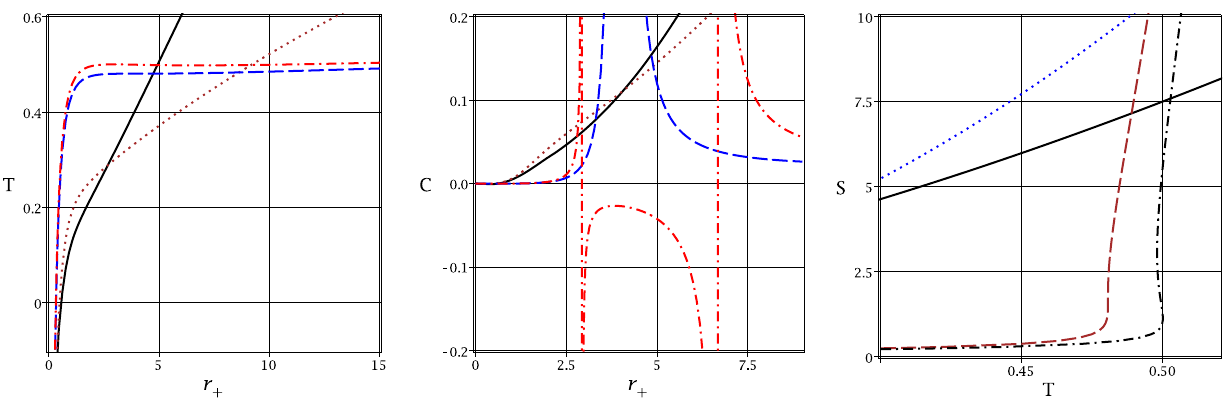
Fig. 2 For k = 1, m = 5, (cid:16) = − 1, b = 1, q = 1, β = 1, f (ε) = g (ε) = 0 . 9, α = 0 (continuous line), α = 0 . 5 (dotted line), α = 0 . 79983 (dashed line) and α = 0 . 81 (dashed-dotted line). T (left panel) and C (middle panel) versus r + ; S versus T (right panel)